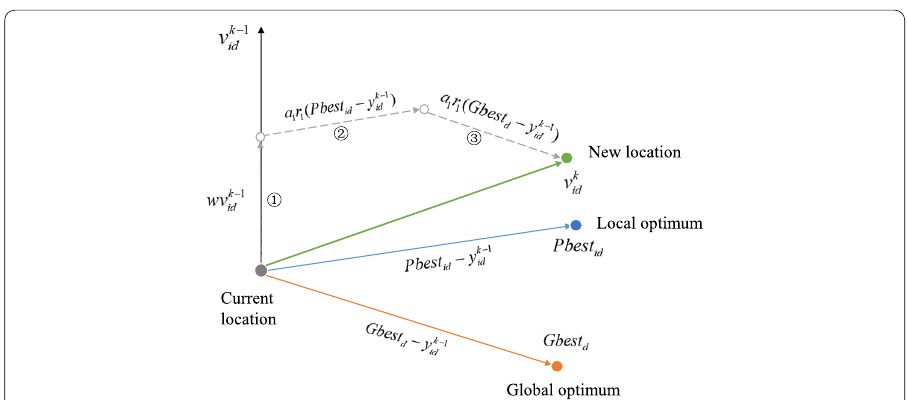
Fig. 2 Schematic diagram of particle motion